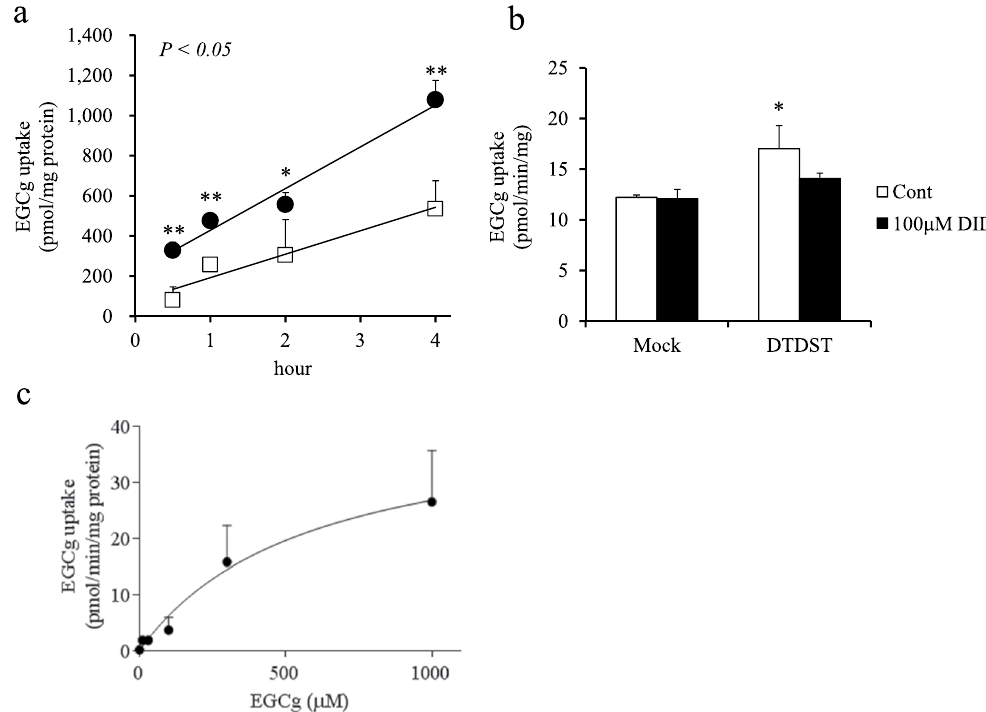
Figure 4. ( a ) Time-course data of epigallocatechin gallate (EGCg) uptake by CHO-K1 cells stably expressing diastrophic dysplasia sulfate transporter (DTDST; ● ) or mock cells ( □ ) (n = 4/group) incubated with 500 μ M EGCg. Linear approximation was performed and the line is shown. Two-factor repeated measures ANOVA was used to evaluate the group-by-time interaction and the P value is shown in the upper-left of the panel. Data are presented as mean ± SD. Significant differences as determined by means of Student’s t -test are indicated by * ( P < 0.05) and ** ( P < 0.01). ( b ) EGCg uptake by CHO-K1 cells stably expressing DTDST or mock cells after treatment with the DTDST inhibitor 4,4 ′ -diisothiocyano-2,2 ′ -stilbenedisulfonic acid (DIDS) or vehicle (n = 3/ group) incubated with 500 μ M EGCg for 30 min. Data are presented as mean ± SD. Significant differences as determined by Student’s t -test are indicated by * ( P < 0.05). ( c ) Kinetics of EGCg uptake mediated by DTDST after subtracting the values obtained with mock cells (n = 4). CHO-K1 cells stably expressing DTDST or mock cells were incubated with EGCg at concentrations ranging from 1 to 1000 μ M for 30 min. Data are presented as mean ± SD. The kinetic parameters were obtained by fitting the data to the Michaelis–Menten equation in the enzyme kinetics module of GraphPad Prism software Version